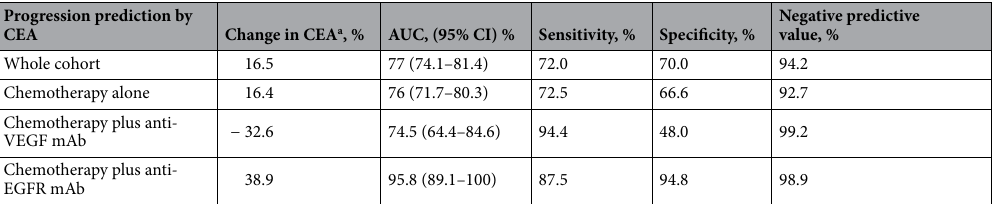
Bivariable logistic regression Multivariable logistic regression Unadjusted OR 95% CI P-value Adjusted OR 95% CI P-value Elevated CEA changes above the cut-off value ( vs those below the cut-off value a